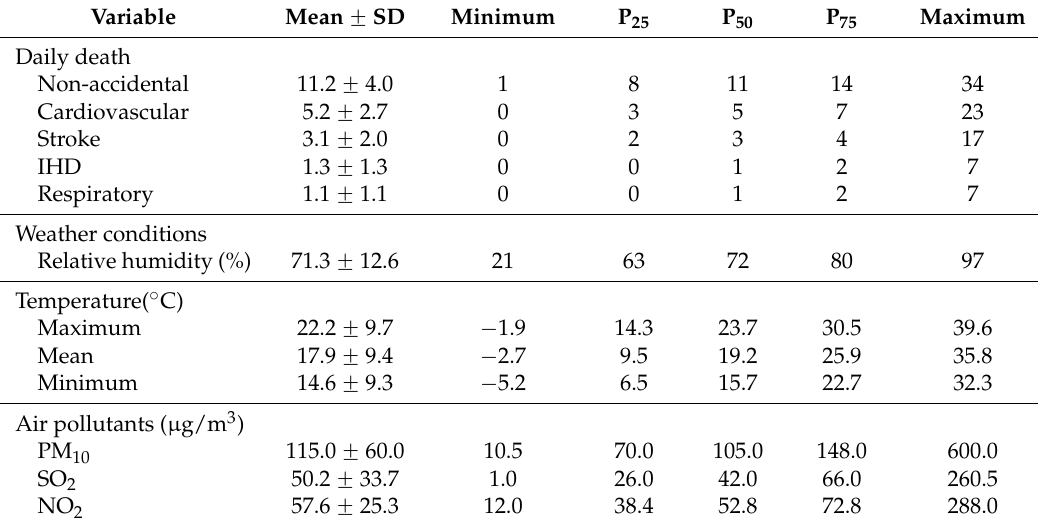
Table 1. Descriptive statistics of daily cause-specific mortality, weather conditions, and air pollutants in Jiang’an District of Wuhan, China, 2003–2010.